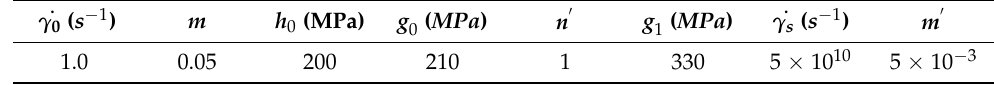
Table 3. Fitted plastic constants of IN-738 LC at 850 ◦